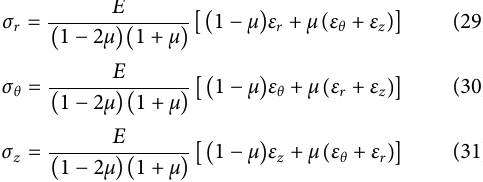
FIGURE 8 Schematic diagram of the shoulder pad